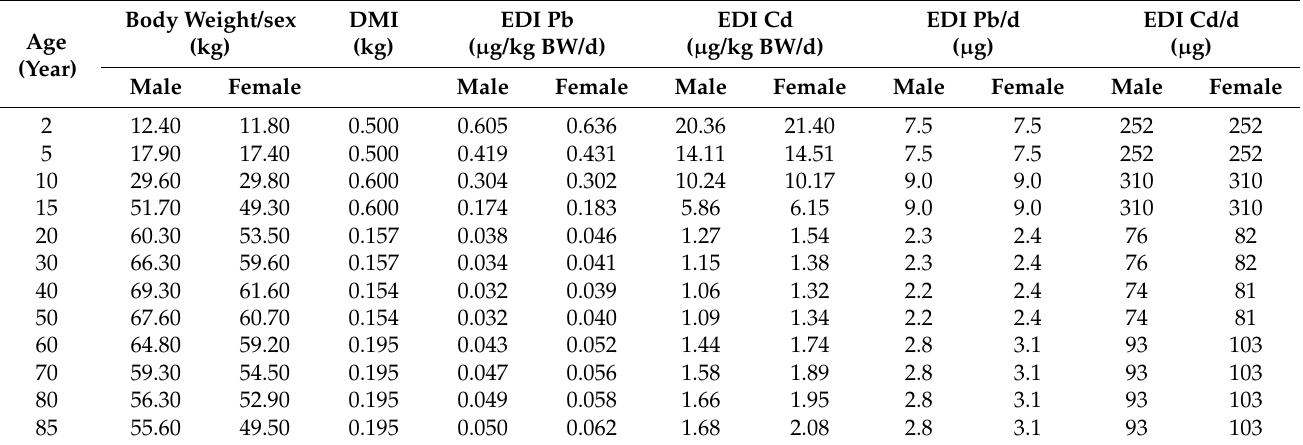
Table 4. Daily Pb and Cd exposure from milk consumption in populations aged 2–85 years—Per ú